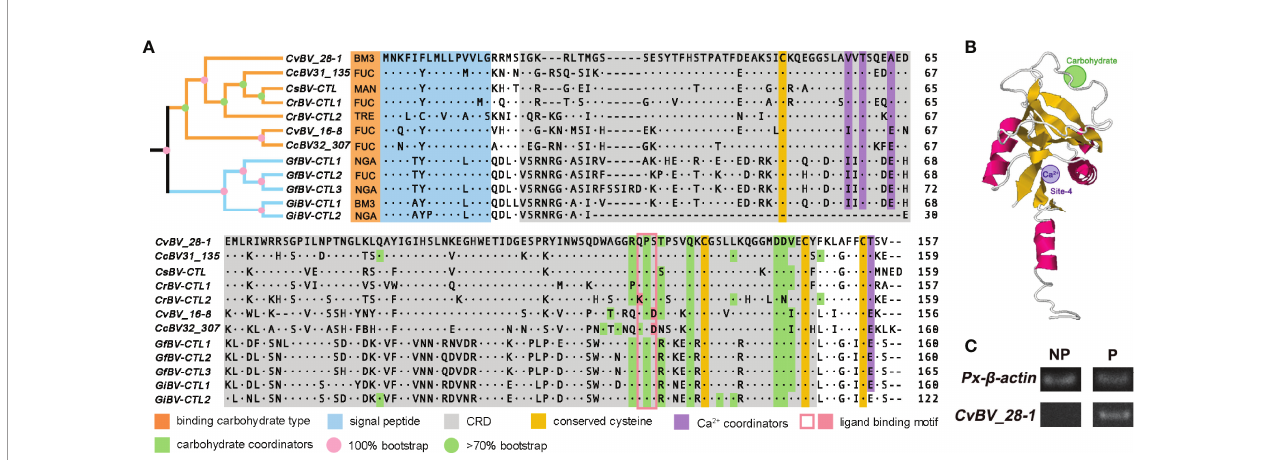
FIGURE 2 | Phylogenetic analysis and spatial architecture of two CTLs of CvBV. (A) Multiple sequence alignment and phylogenetic analysis of the CTLs of different PDVs. The gene architecture is shown with a signal peptide in blue, CRD motif in gray, four conserved cysteines in yellow, Ca 2+ coordinators in purple, a ligand binding motif in pink and carbohydrate coordinators in green. The types of binding carbohydrates are marked in orange. Yellow and blue branches indicate Cotesia and Glyptapanteles species, with the level of bootstrap in pink and green circles. The numbers on the right are the positions of the fi nal amino acids. BM3, N-acetyl- a -D-mannosamine; FUC, a -L- fucopyranose; MAN, b -D-mannose; TRE, trehalose; NGA, N-acetyl-D-galactosamine. (B) Predicted spatial architecture of CvBV_28-1 . The position of the Ca 2+ binding site of CvBV_28-1 is marked in purple, and the carbohydrate binding site is marked in green. (C) PCR analysis of CvBV_28-1 in DNA of parasitized and nonparasitized host larvae. Px- b -actin expression was served as control. Representative images from three independent replicates are